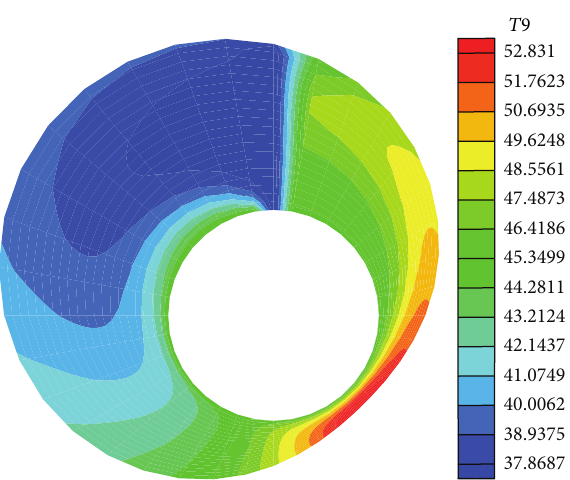
Figure 11: Isothermal lines of the journal bearing at its central plan for 𝜀 = 0.8 and 𝑛 = 0.9 .